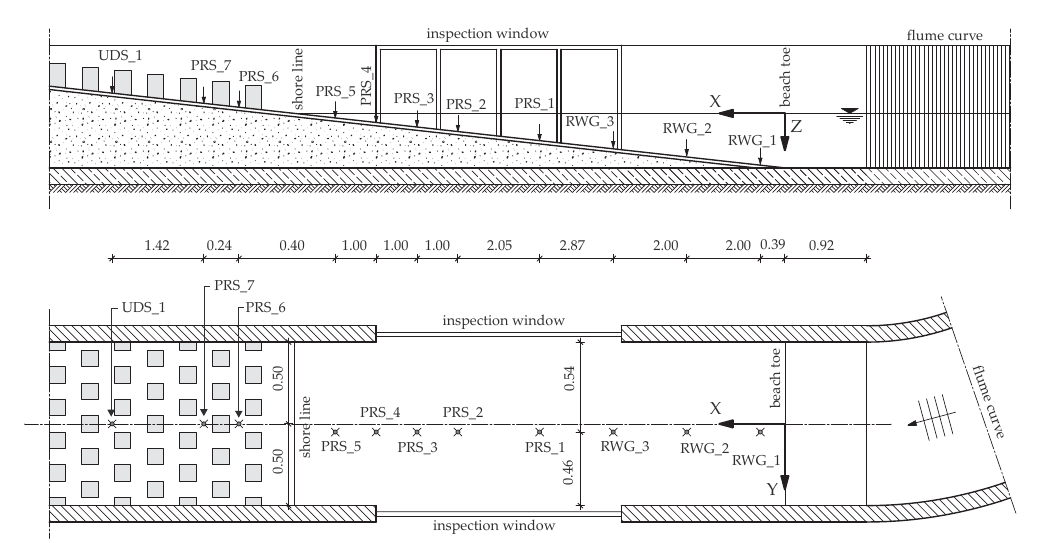
Fig. 6. Layout drawing of the laboratory instrumentation with used pressure sensors and wave gauges for the experimental set-up, abbrevia- tions denote the following devices: PRS – pressure sensor, RWG – resistance wave gauge, UDS – ultrasonic distance sensor; for more than one device consecutive numbers are given, not to scale (units in metre), note that some sensors are not analysed in this